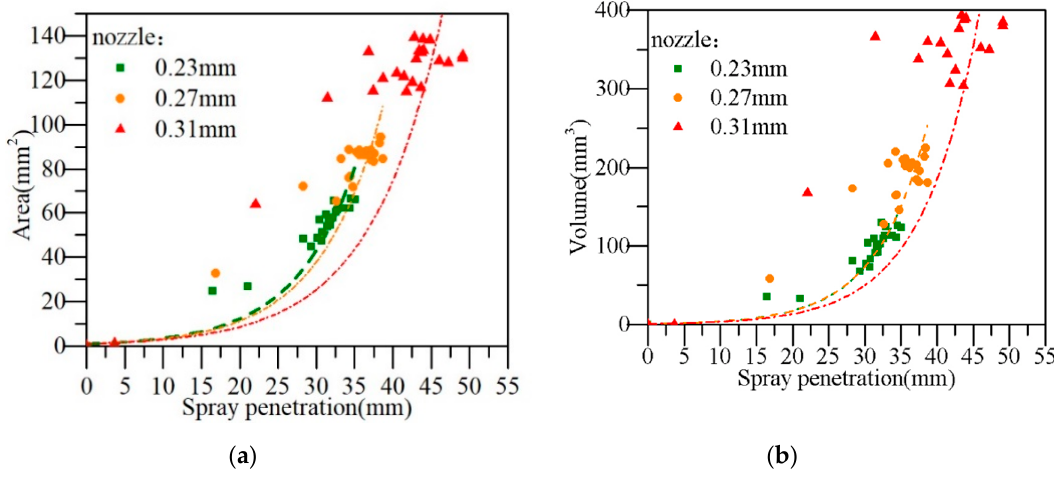
Figure 9. The spatial relationship between the spray spreading area ( a ) and spray penetration, spray volume and the spray penetration ( b ).